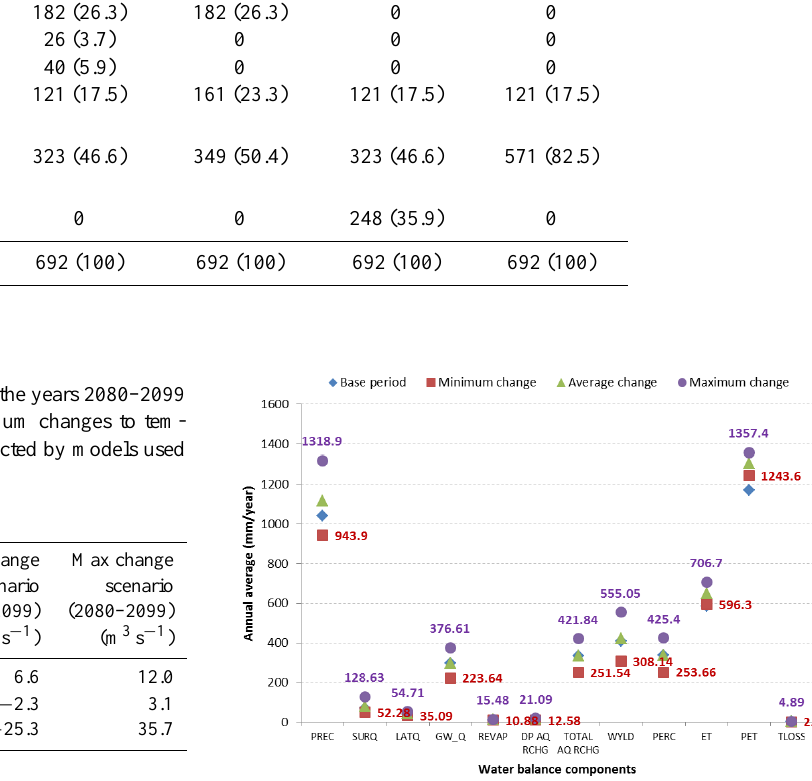
Figure 10. Nyangores water balance components for the base period (2006-2008) and climate change scenarios. Different scenarios are described in Table 6. Fig. 10. Nyangores water balance components for the base period (2006–2008) and climate change scenarios. Different scenarios are described in Table